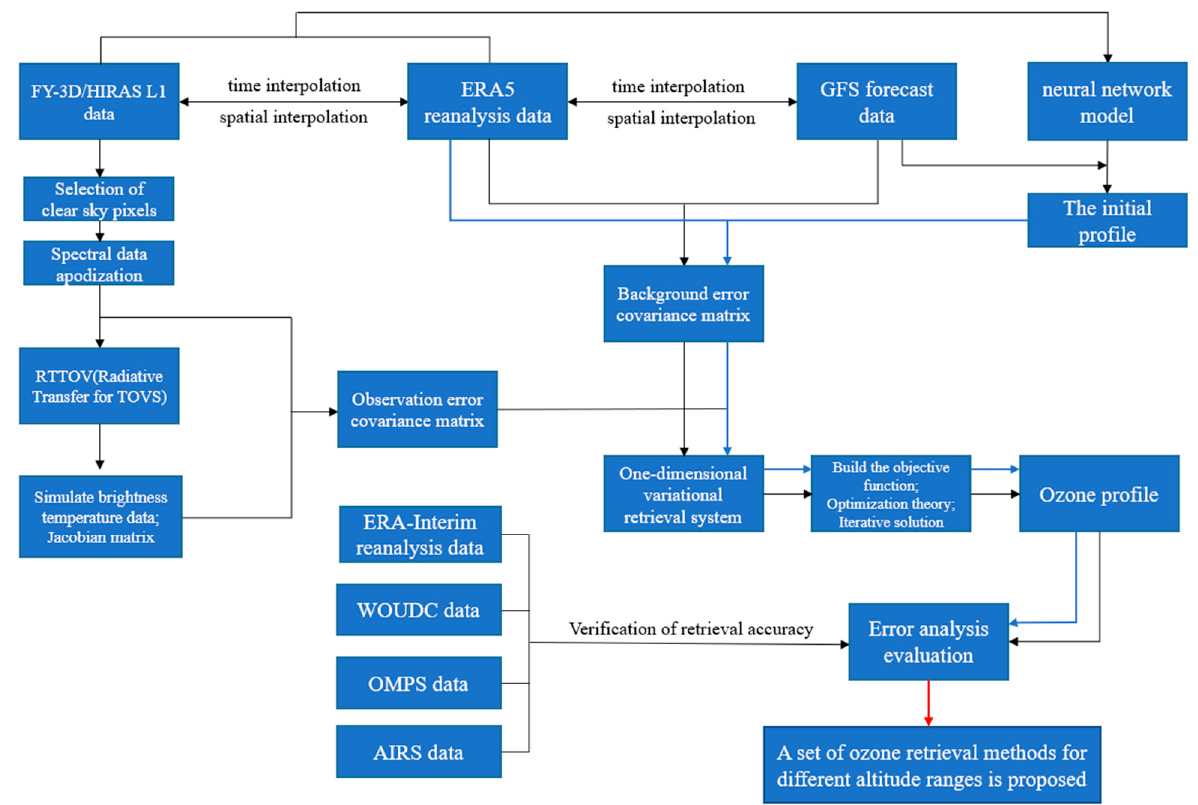
Figure 4. Set-up of the retrieval system.